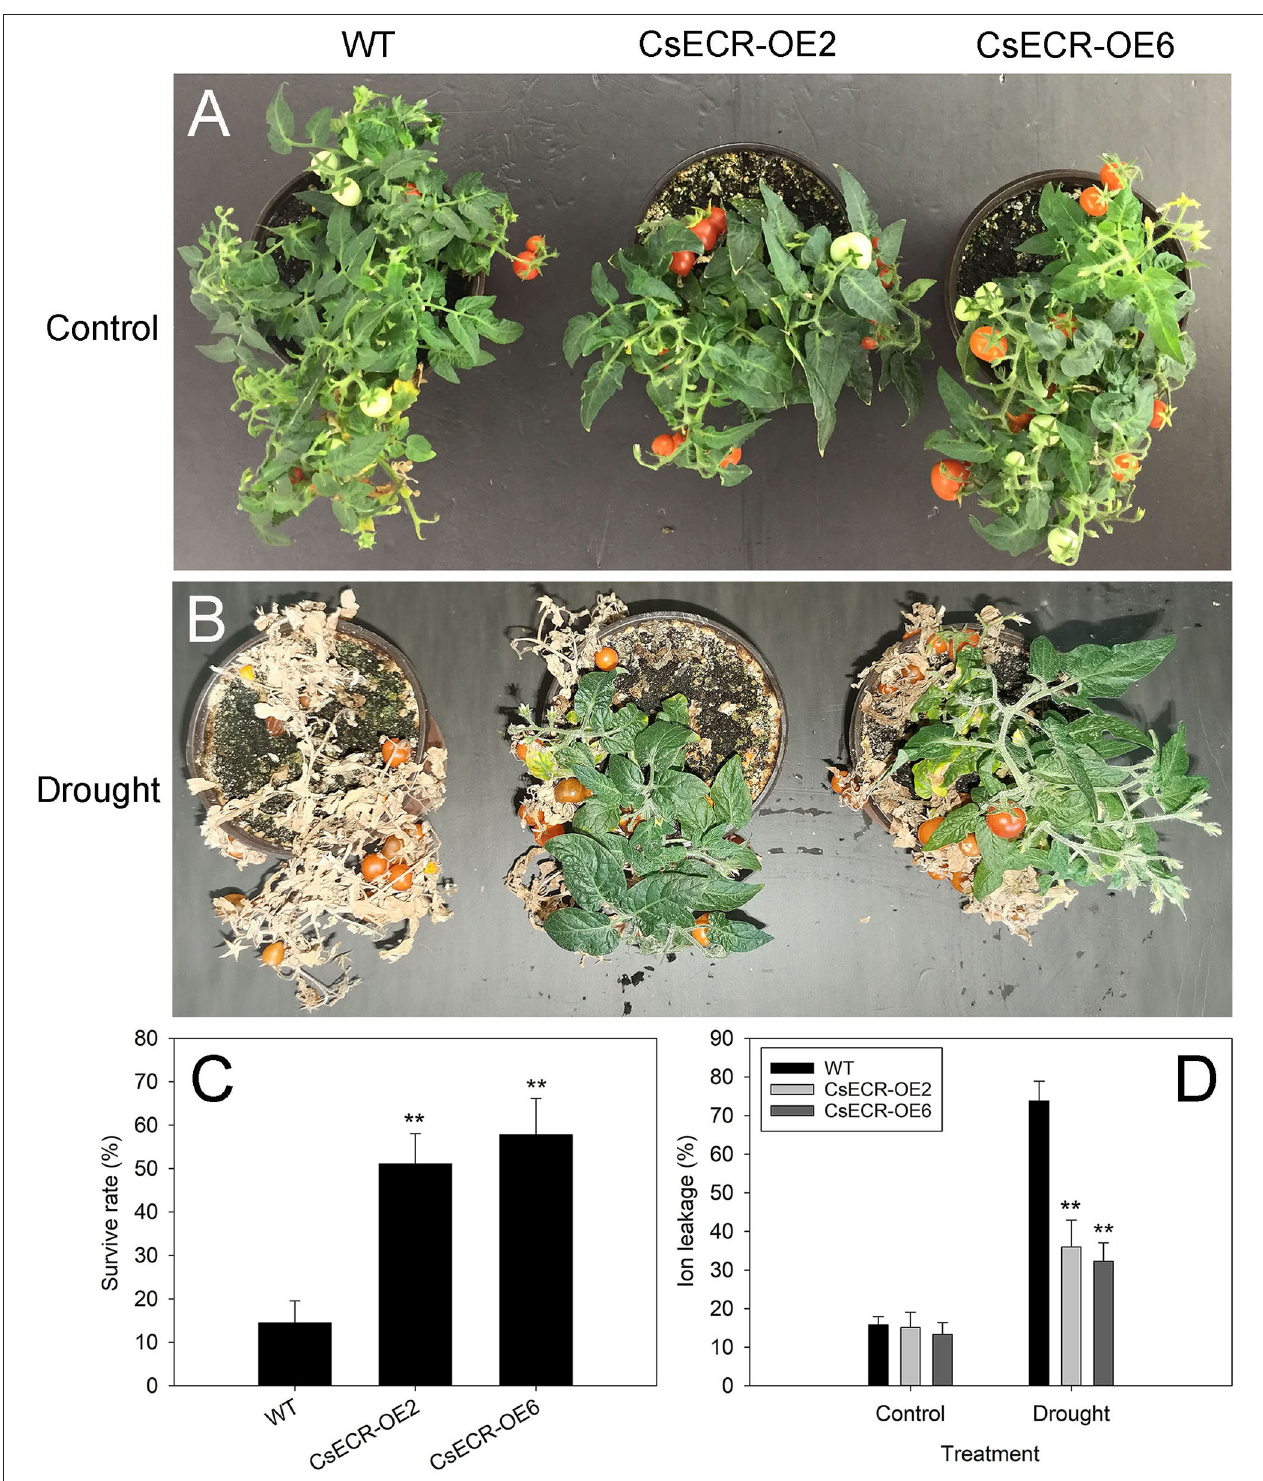
FIGURE 8 | Phenotype (A,B) , survival rate (C), and ion leakage (D) in the WT and two transgenic tomato lines (CsECR-OE2 and CsECR-OE6) under drought stress (without watering for 15 days before re-watering for 5 days). Vertical bars represent standard deviations of the means ( n = 3). Significant differences between the WT and transgenic tomato lines at the P < 0.01 levels were indicated by double asterisks according to Student’s t -test.